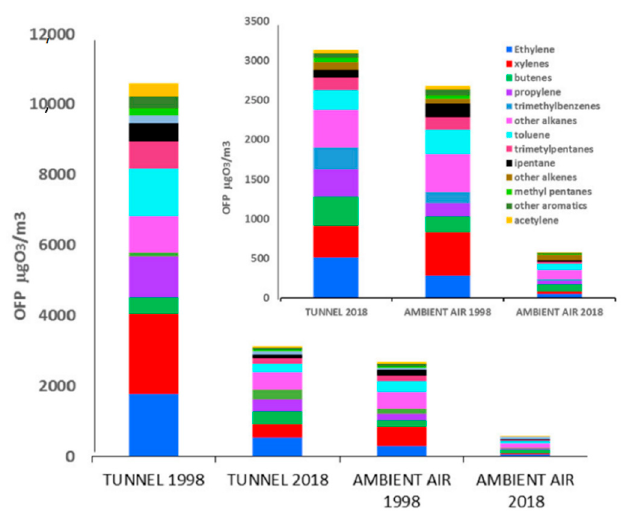
Figure 7. Main VOC contributors to photochemical ozone formation in tunnels and ambient air.